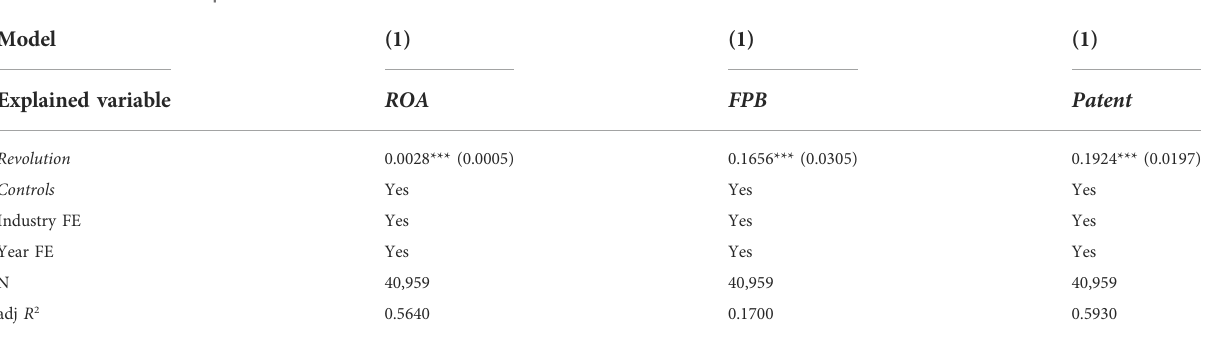
TABLE 8 Economic consequence